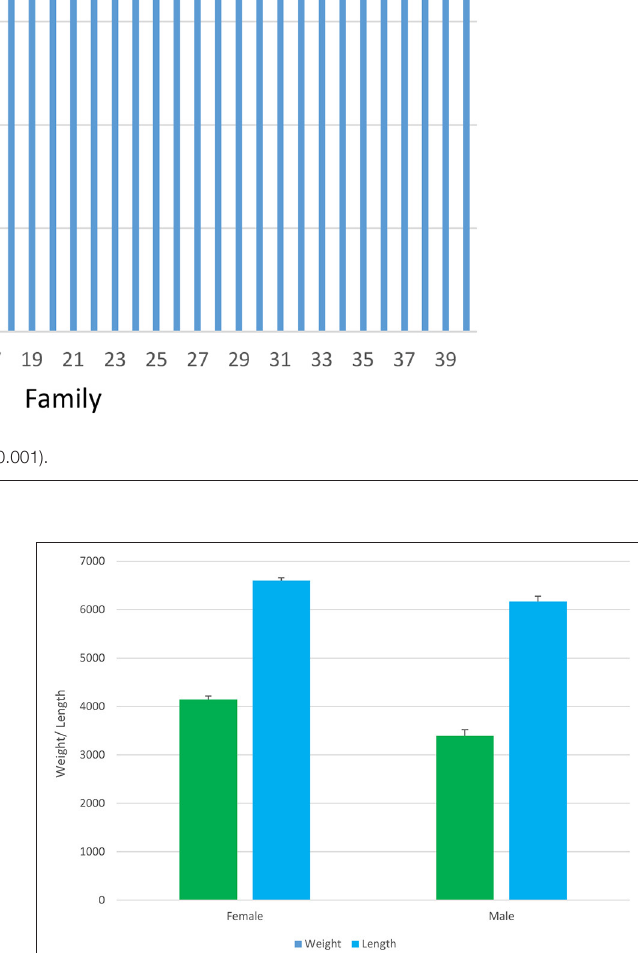
FIGURE 2 | Fish body weight in cage ( n different measurement periods at 105, 220, and 270 days post-hatch ( P < 0.001).